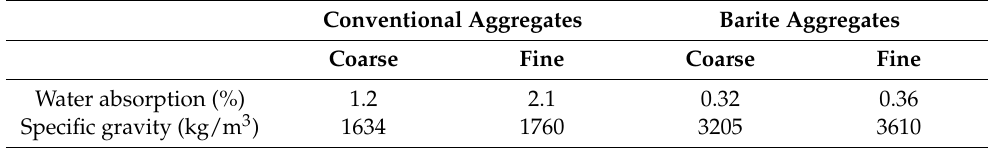
Table 1. Physical and mechanical properties of